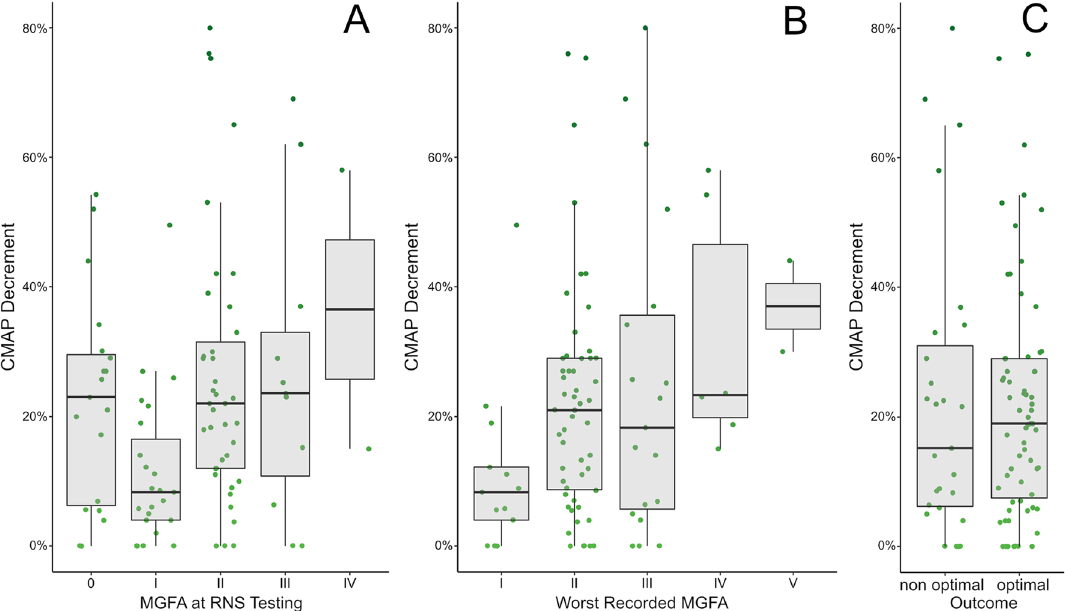
Figure 3. Correlation of CMAP decrement and clinical state: Data are presented on a group level (boxplot) and for each individual patient (green dots). ( A ) No clear correlation between clinical severity at testing and CMAP decrement exists, mainly because clinically asymptomatic patients still exhibit pathologic decrements at RNS ( B ) Correlation of CMAP decrement with the worst recorded MGFA is evident on the group level, but patients with the high CMAP decrement did not necessarily develop severe disease or myasthenic crisis during the observed period. ( C ) There is no association of CMAP decrement with the outcome of patients at last